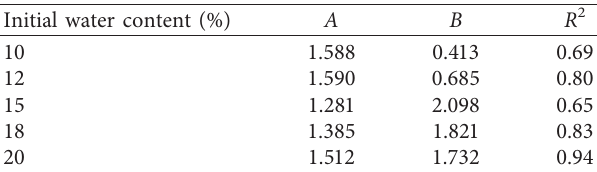
Table 3: A summary of the statistical parameters A and B for the various